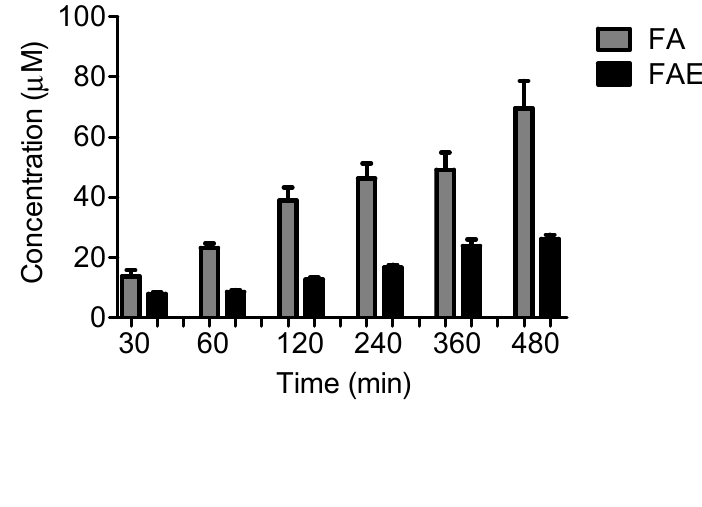
Figure 8. Release profile of creams containing FA and FAEE performed on Franz cells. Data represent the mean and SD of at least 2 different experiments conducted in